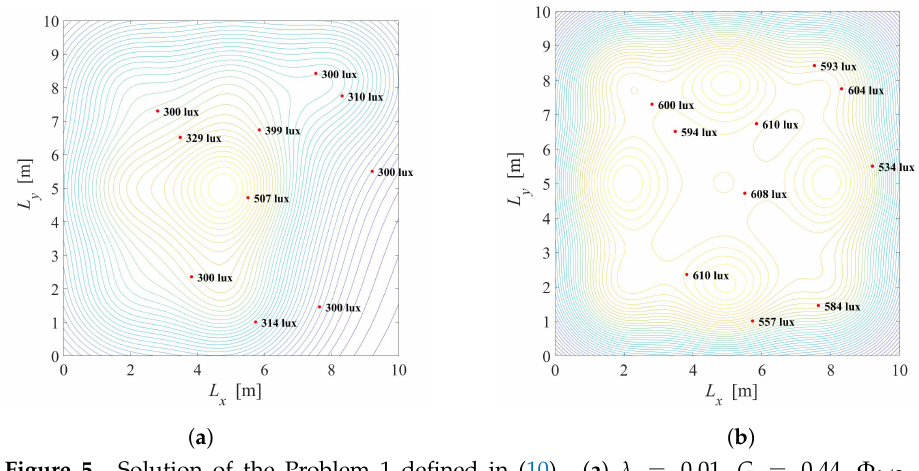
Figure 5. Solution of the Problem 1 defined in (10). ( a ) λ = 0.01, G = 0.44, Φ 1/2 = 60 0 . ( b ) λ = 0.5, G = 0.92, Φ 1/2 = 60 0